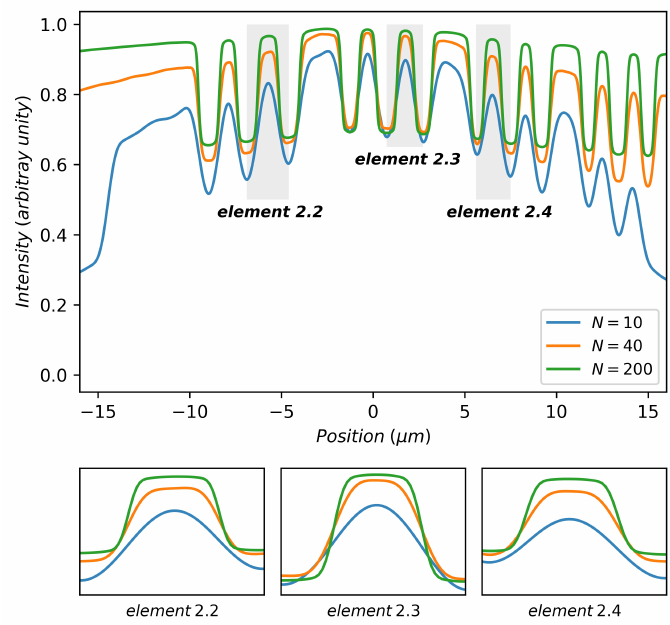
Figure 6. Intensity profile plots of images in focus with various numbers of zones: the images are simulated under the same conditions of Figure 4. Three zoomed parts of plot corresponding to different groups of bars are given below the main